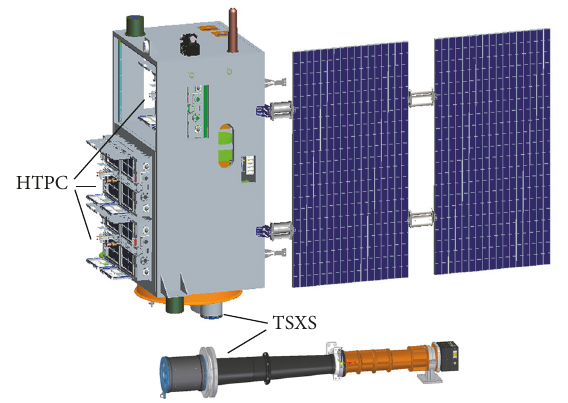
Figure 2: XPNAV-1 satellite structure